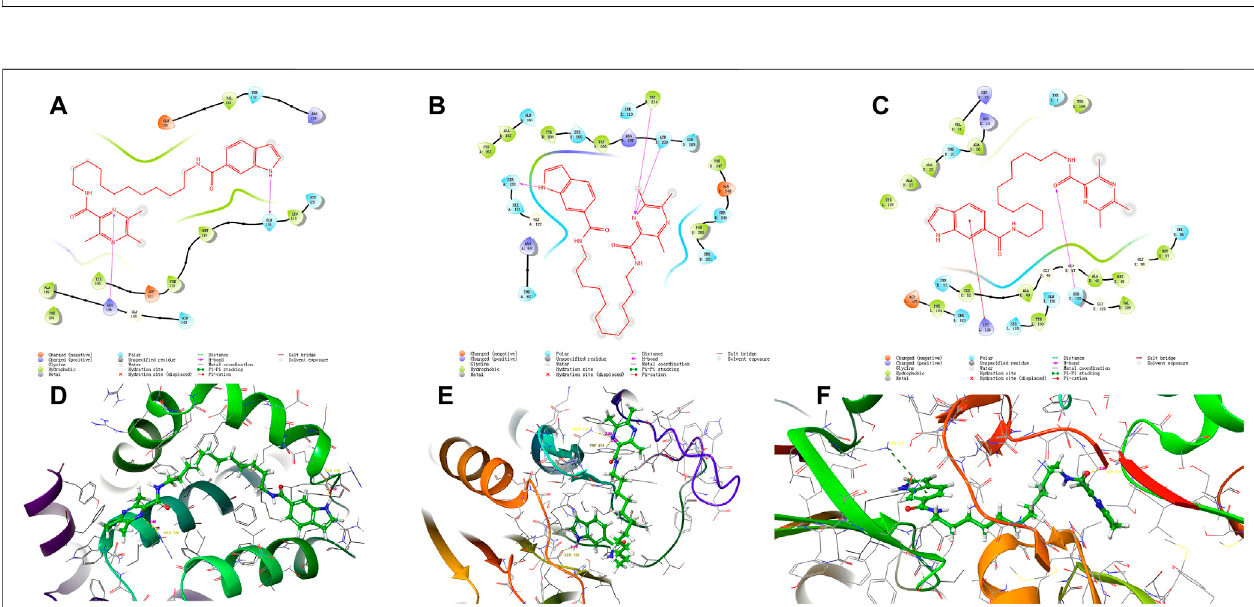
FIGURE 4 | Visual presentation of the interaction of the crystal structure of compound 12 – 9 (shown as stick) with its docked pose of Bcl-2, CASP-3, and PSMB5 and (represented as a secondary structure in green) performed by the Schrodinger. [ (A – C) represented as the ligand interaction diagram with Bcl-2, CASP-3, and PSMB5 respectively. (D – F) represented as binding interactions with Bcl-2, CASP-3, and PSMB5, respectively.].